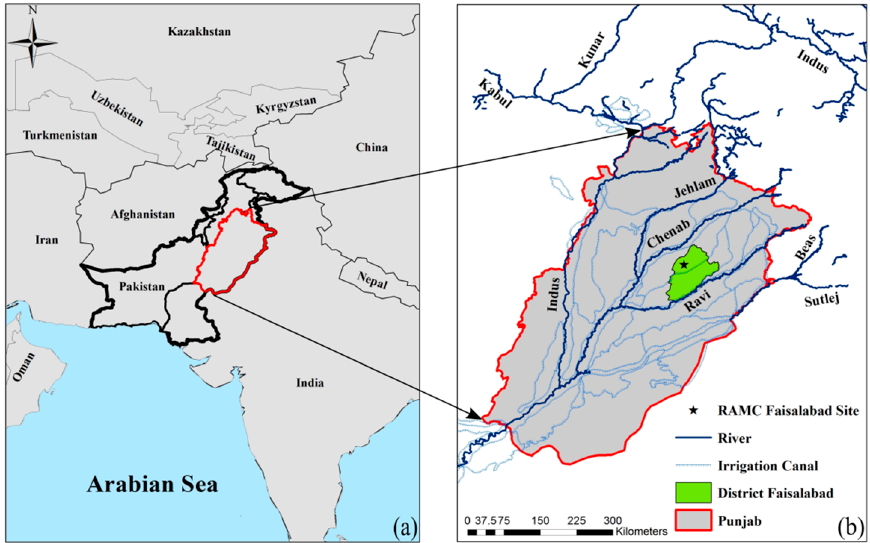
Figure 1. Location of ( a ) Punjab and ( b ) study site in district Faisalabad.